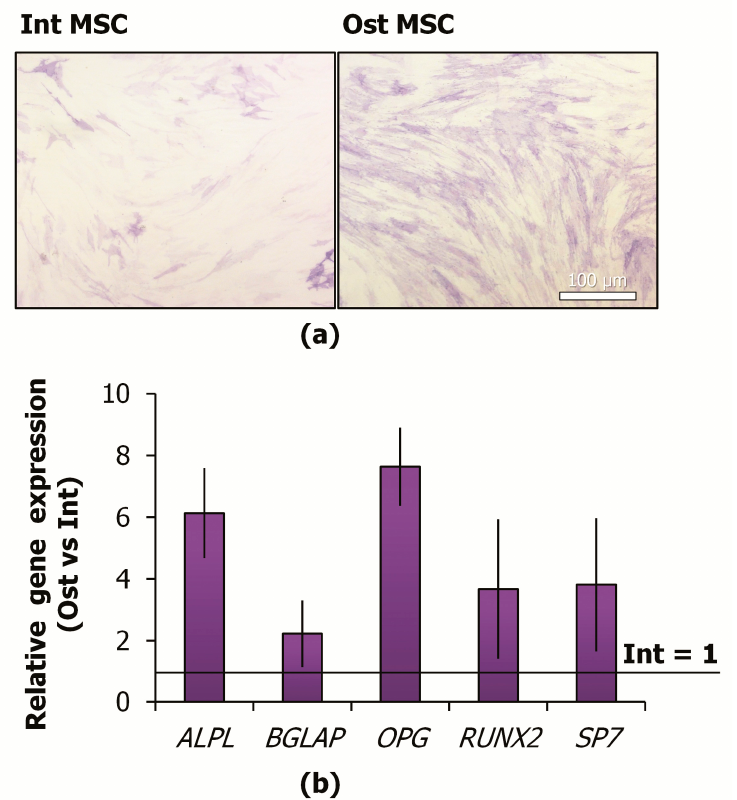
Figure 2. Confirmation of MSC osteogenic commitment (7-day induction): ( a ) representative im- ages of histochemical detection of ALP activity and dye optical density of alkaline phosphatase activity staining, light microscopy (bright-field); ( b ) relative expression of osteogenesis-associated genes (Ost vs. Int), qPCR analysis. MSCs—mesenchymal stromal cells; Int—intact MSCs; Ost—osteocommitted MSCs.